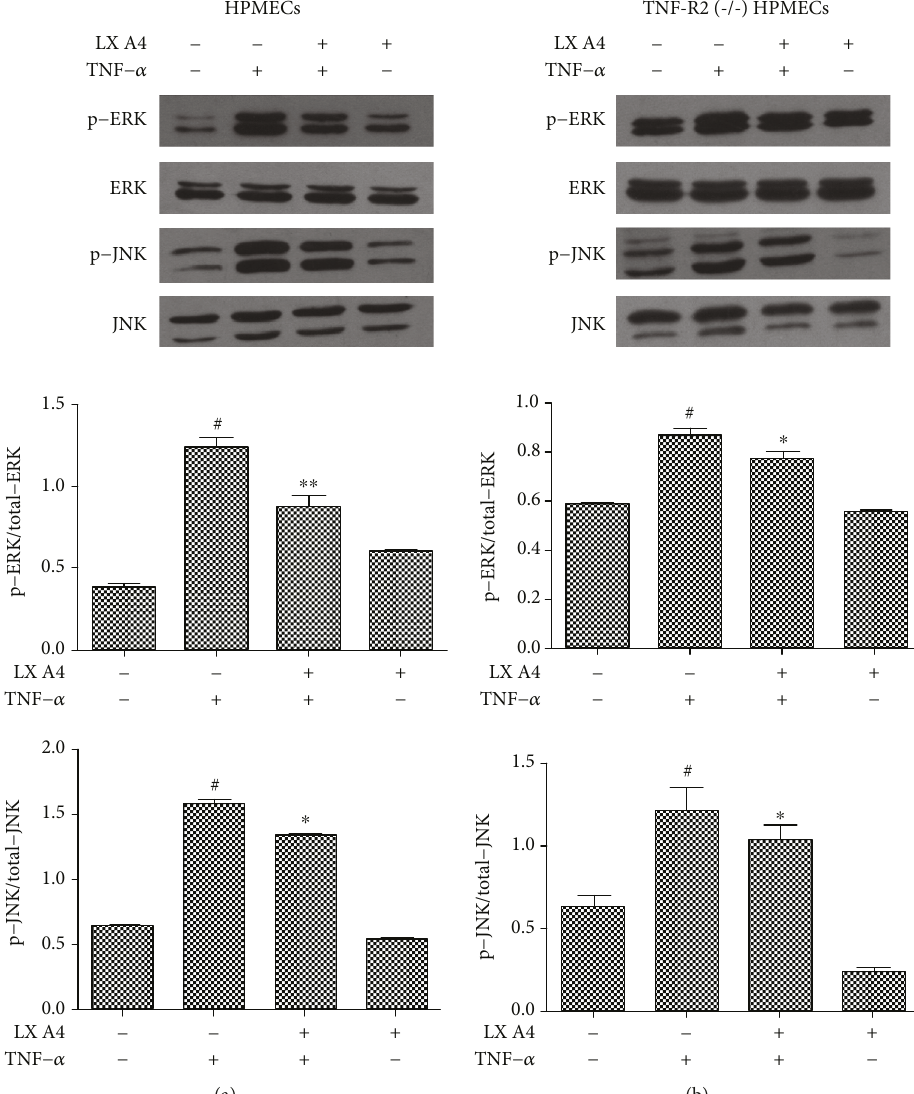
Figure 3: Inhibition of TNF- α induced activation of JNK/MAPK and ERK/MAPK by AT-Lipoxin A4. HPMECs and TNF-R2 (-/-) HPMECs were pretreated with AT-Lipoxin A4 (50 ng/mL) for 1 h and then stimulated with TNF- α (50 ng/mL) for another 15 min. (a) Western blot assay shows expressions of p-ERK, ERK, p-JNK, and JNK in HPMECs. (b) Western blot assay shows expressions of p-ERK, ERK, p-JNK, and JNK in TNF-R2 (-/-) HPMECs. The data showed representatives of at least three independent experiments. # P < 0 01 compared with the control, ∗ P < 0 05 compared with TNF- α in the absence of AT-Lipoxin A4, and ∗∗ P < 0 01 compared with TNF- α in the absence of AT-Lipoxin